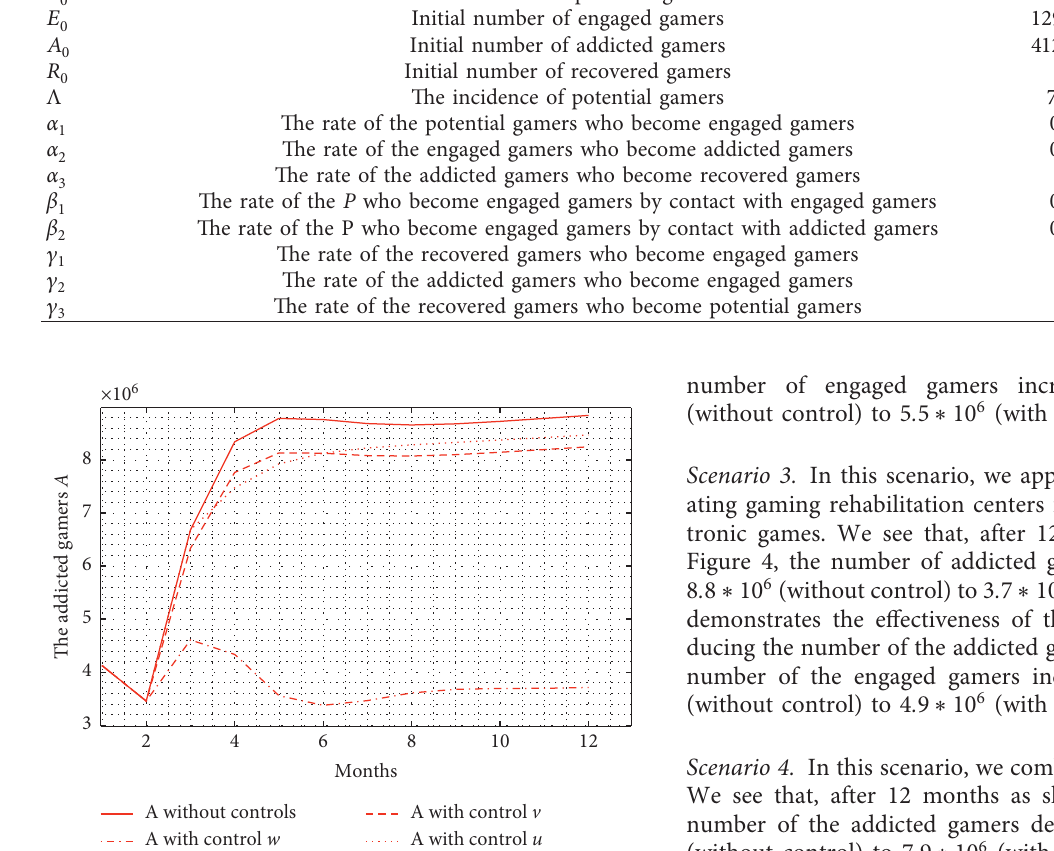
Figure 4: Development of the number of the addicted gamers with one control in a few months.